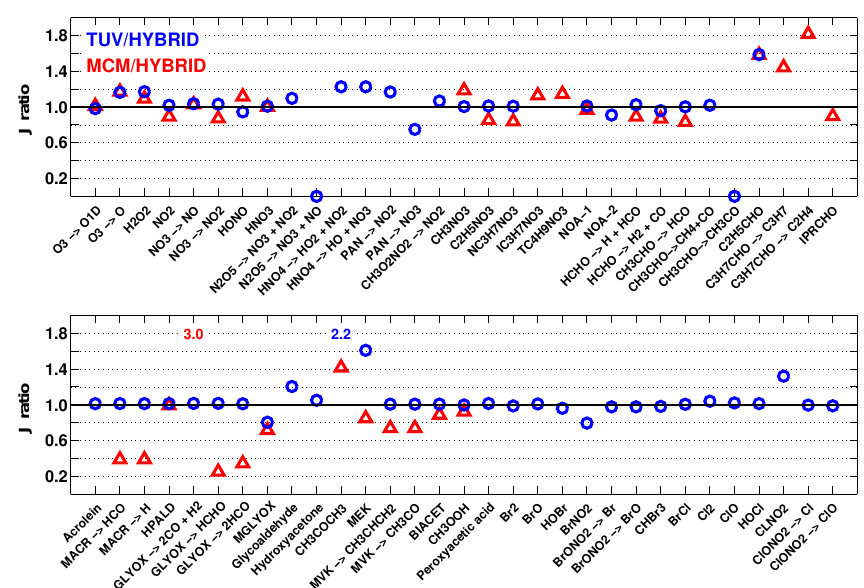
Figure 2. Ratio of photolysis frequencies calculated from the MCMv3.3.1 SZA parameterization (red triangles) and TUVv5.2 (blue cir- cles) against the F0AM hybrid method. Ratios are taken for J values calculated with a single set of inputs (SZA = 0 ◦ , altitude = 0.5km, albedo = 0.01, O 3 column = 350 DU). Blue and red numbers denote values falling outside the y axis range. The hybrid scheme includes photolysis frequencies for all listed reactions. Reactions with missing values do not have TUV or MCM